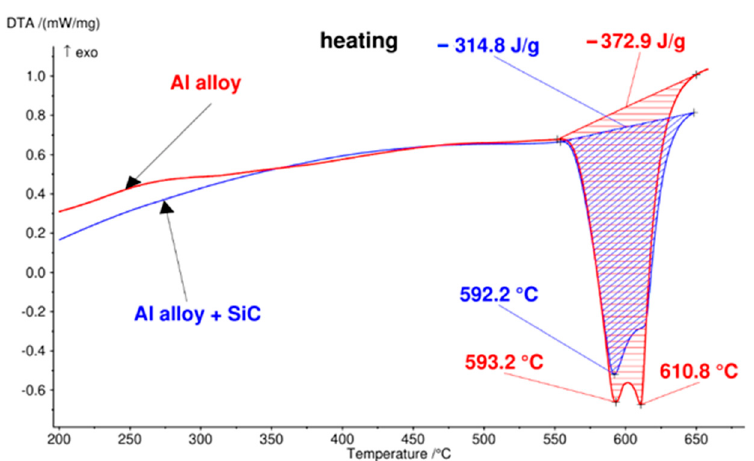
Figure 8. Differential thermal analysis (DTA) curves during heating for aluminum alloy and for the composite aluminum alloy—SiC particles.